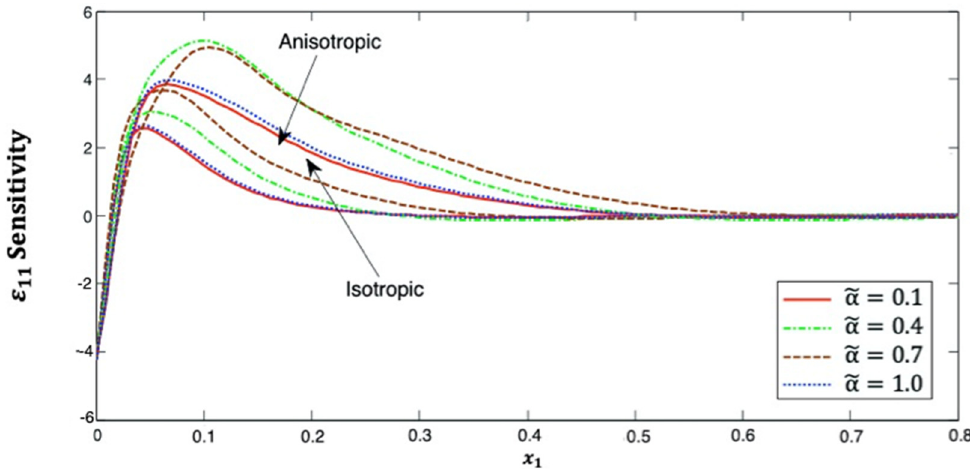
Figure 8. Distribution of the ε 11 sensitivity along x 1 –axis in isotropic and anisotropic FRP composites for various fractional-order values.